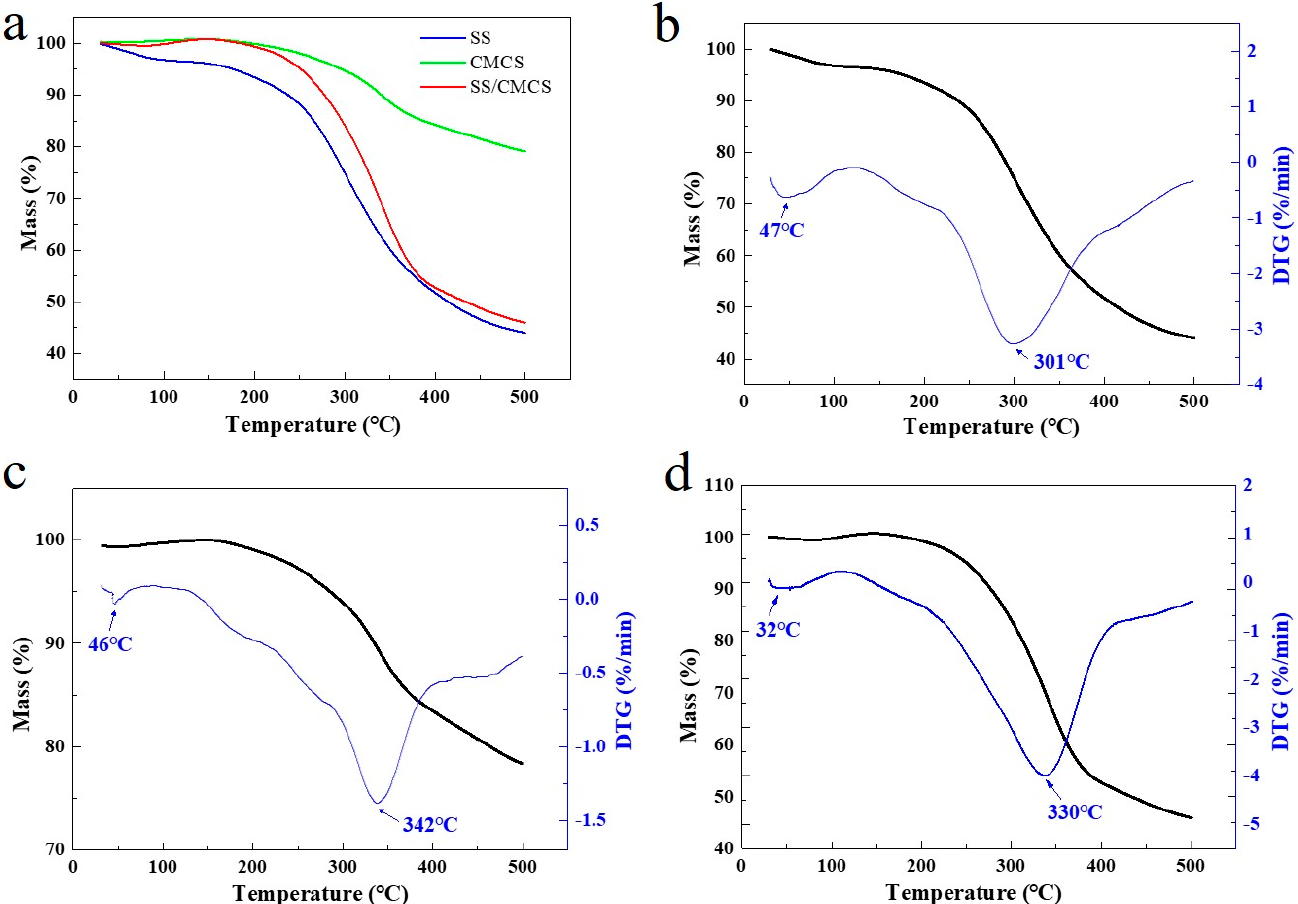
Figure 2. ( a ) TGA curves for the decomposition of freeze-dried SS solution, CMCS hydrogel, and SS/CMCS hydrogel; TGA-DTG profiles for freeze-dried ( b ) SS solution, ( c ) CMCS hydrogel, and ( d ) SS/CMCS hydrogel.